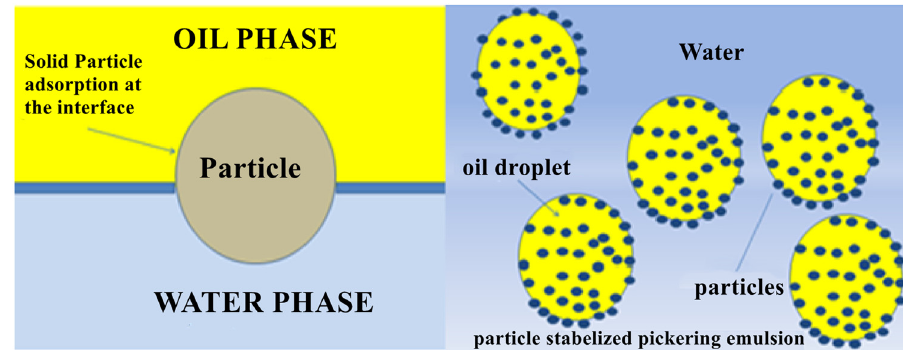
Figure 9: Emulsion stabilization by adsorption of solid particles at oil – water interface [ 199 ]